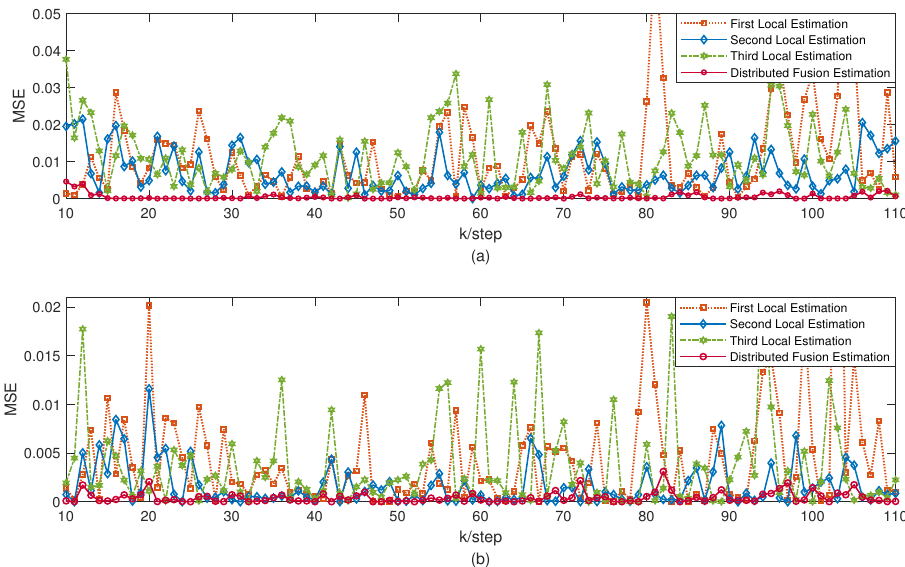
Figure 5. The performance comparison between local estimators and distributed fusion estimator. ( a ) Comparison of estimated mean square error of state. ( b ) Comparison of the estimated mean square error of disturbance.